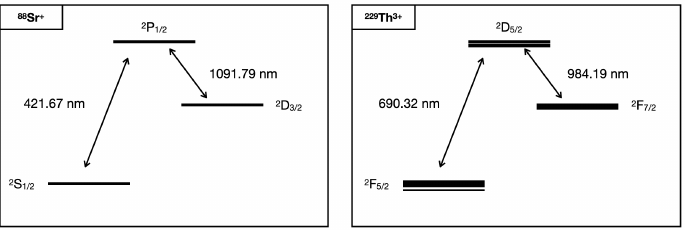
Figure 2. The relevant level schemes of singly charged 88 Sr and triply charged 229 Th . The presence of the hyperfine structure is indicated by the broadened width of the